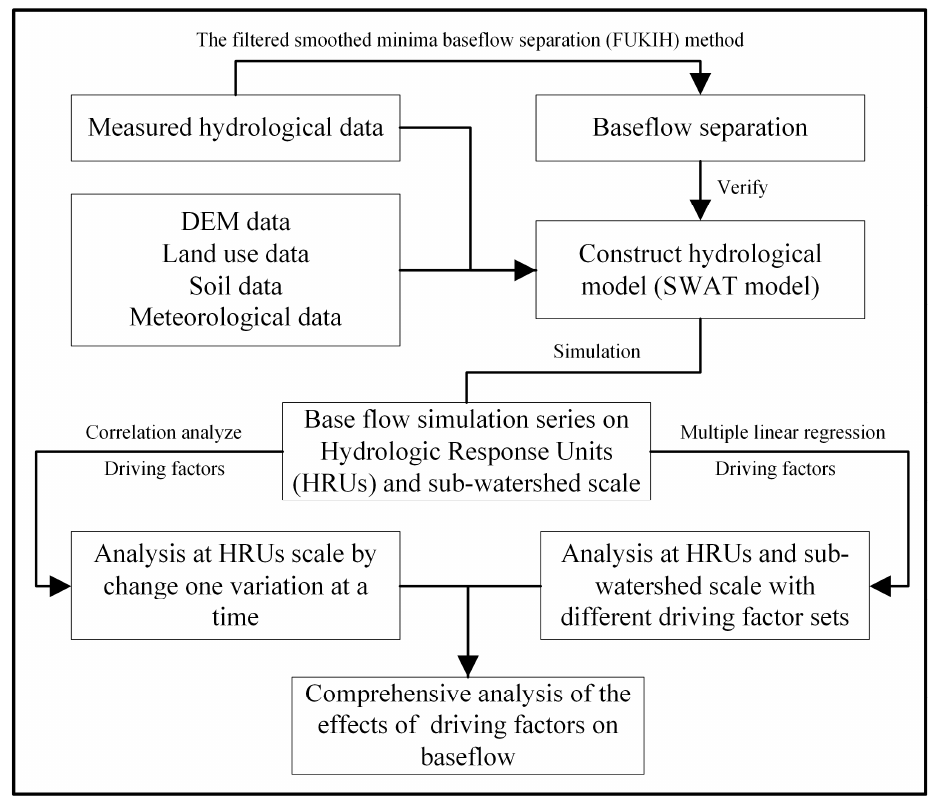
Figure 2. Workflow of the research.